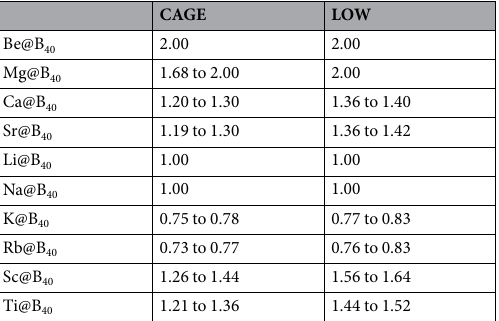
Table 2. The charge transfer of the decorating atoms in the borospherene cage structure and the lowest energy structure.